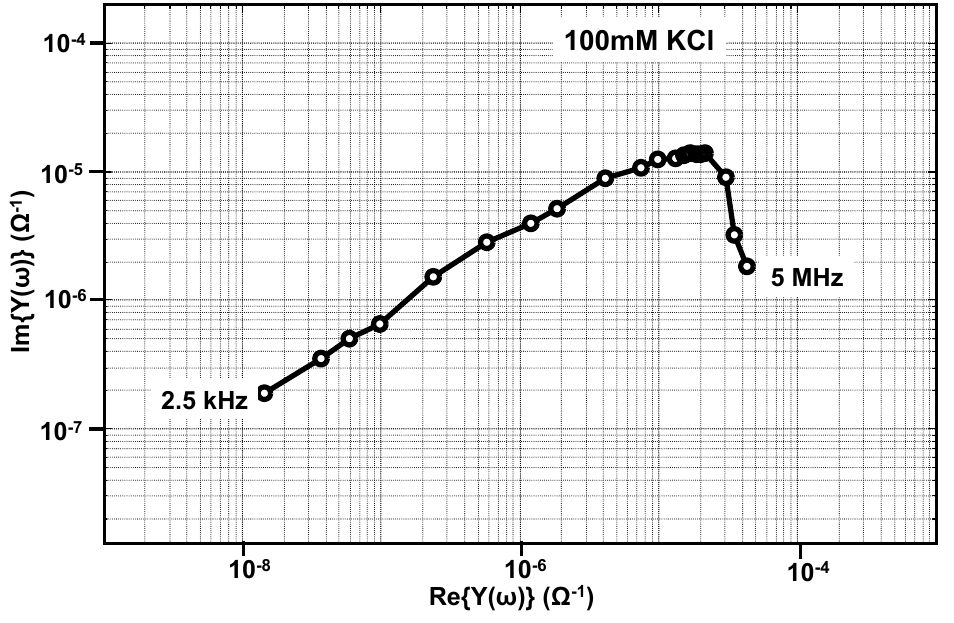
Figure 14. Admittance spectra of 100 mM